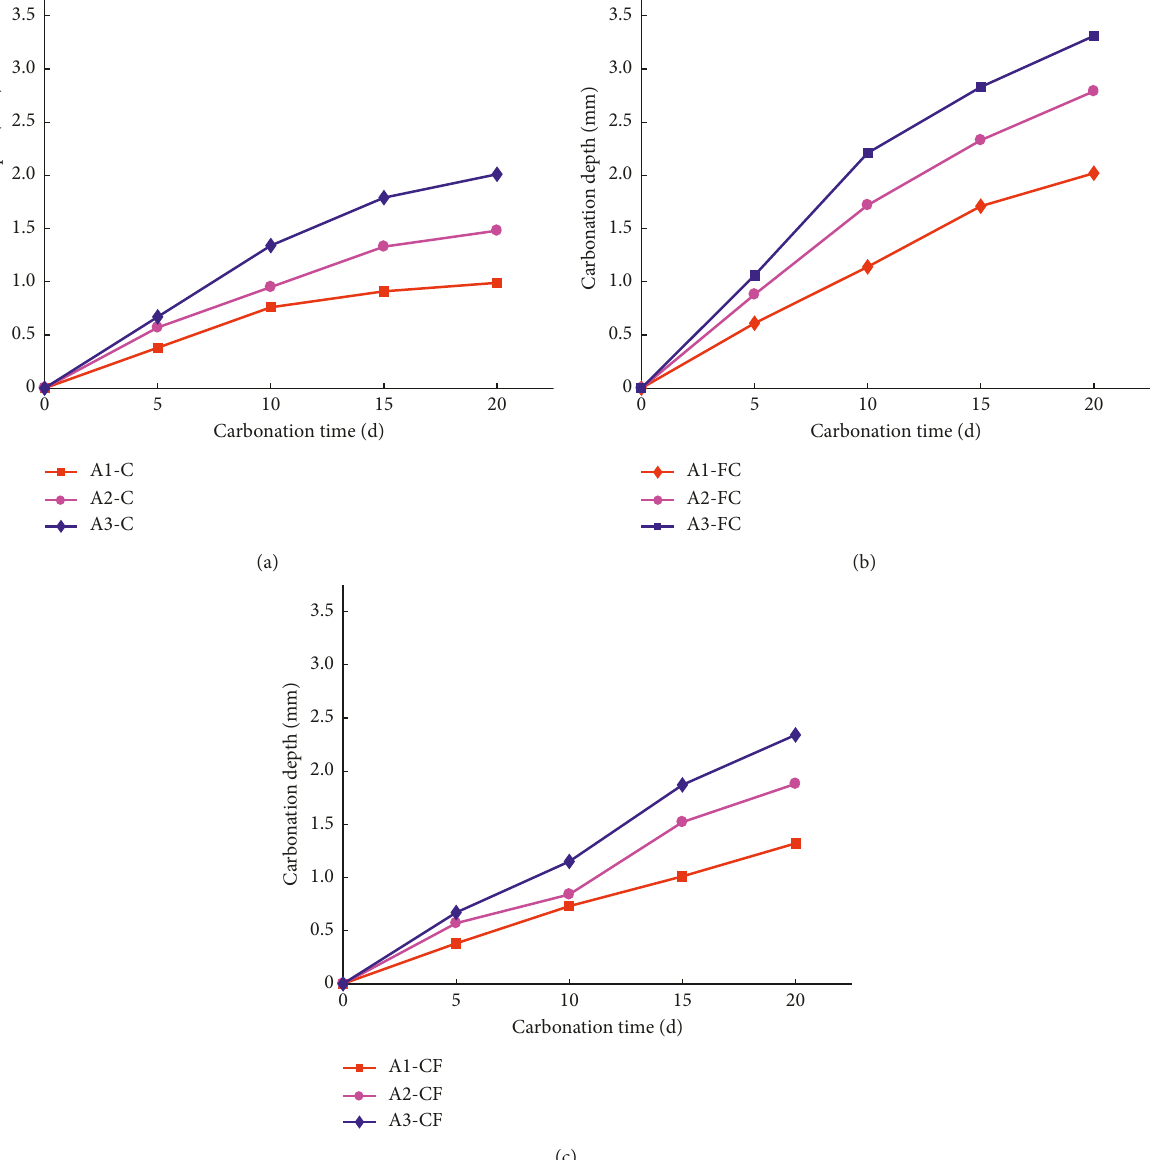
Figure 10: Carbonation depth of A1, A2, and A3 in different testing modes: (a) C mode; (b) FC mode; (c) CF